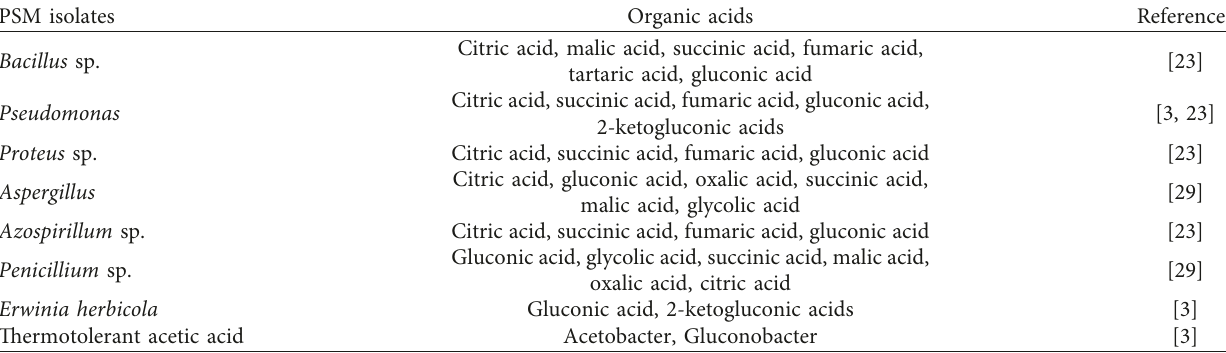
Table 2: Diversity of organic acid produced by